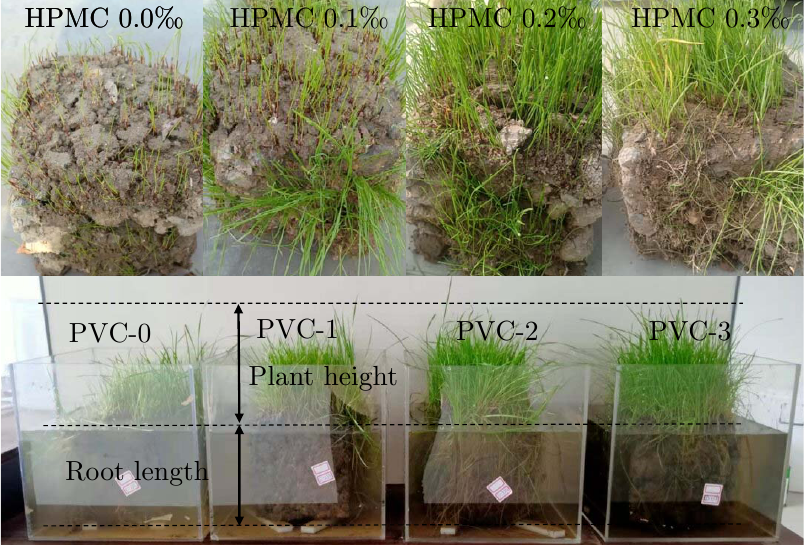
Figure 7. Photographs of vegetation in the four types of PVC samples at 14 days and water planting after 28